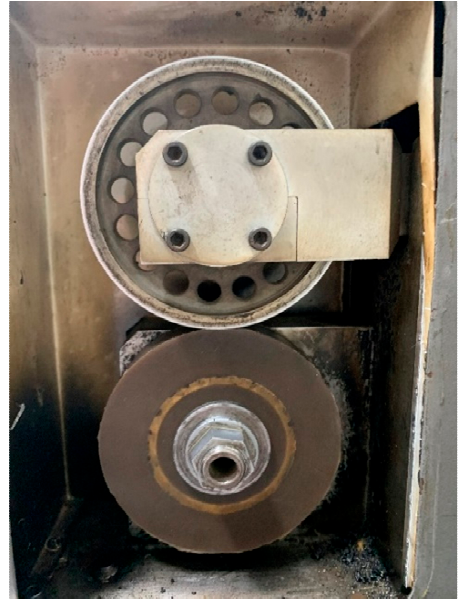
Figure 2. The RSS − II rolling resistance tester for solid rubber tires.